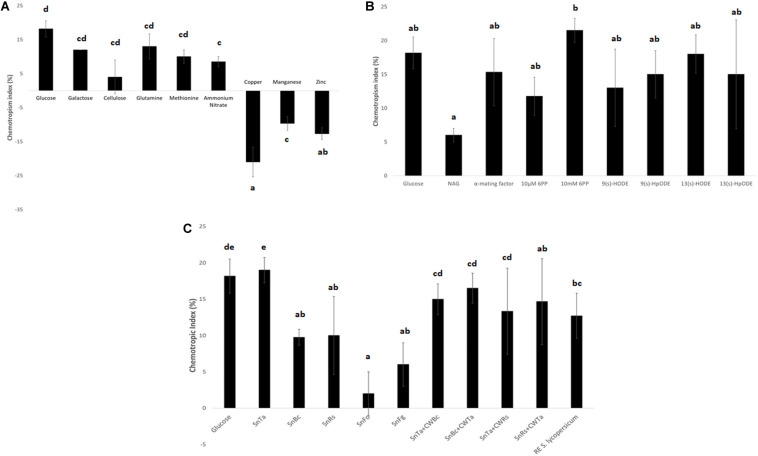
Chemotropic responses to different classes of test compounds. (A) Elementary nutrients and toxins: glucose and copper were confirmed as highly chemoattractive and chemorepellent control compounds for T. atroviride. Furthermore, the assay reflects the declining cellular preference for the compared C- and N-sources with decreasing CI values (see text for details). (B) Elementary self and non-self signaling compounds: 10 mM 6PP of T. atroviride and the plant oxylipin 13(s)-HODE stand out as the most potent chemoattractants for T. atroviride, with the highest, yet concentration dependent, positive response to 6PP. (C) Complex self and non-self signaling compounds: in analogy to 6PP, SnTa provides the strongest chemoattractive cue to conidial germlings of T. atroviride. This is followed by root exudate (RE) of Solanum lycopersicum. Furthermore, does the assay reflect the distinction between prey fungi which can easily or hardly be overgrown by T. atroviride, with SnBc and SnRs resulting in much higher CI values than SnFo and SnFg. Liquid culture supernatants generated in the presence of total cell walls extracts (CWE) of another fungal species shifted the CI values in different directions in comparison to Sn alone (see text for details). Different letters indicate significant differences between the different compounds at p ≤ 0.05 using Scheffé test.